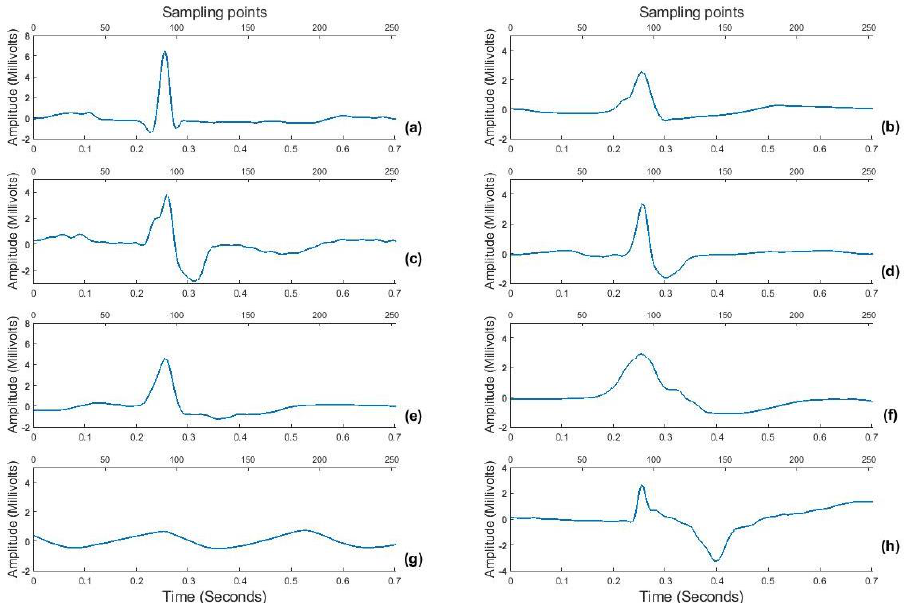
Figure 3. Sample beats for eight ECG beat classes: ( a ) NORM, ( b ) LBBB, ( c ) RBBB, ( d ) PVC, ( e ) PAC, ( f ) VESC, ( g ) VFLT and ( h ) PACE.